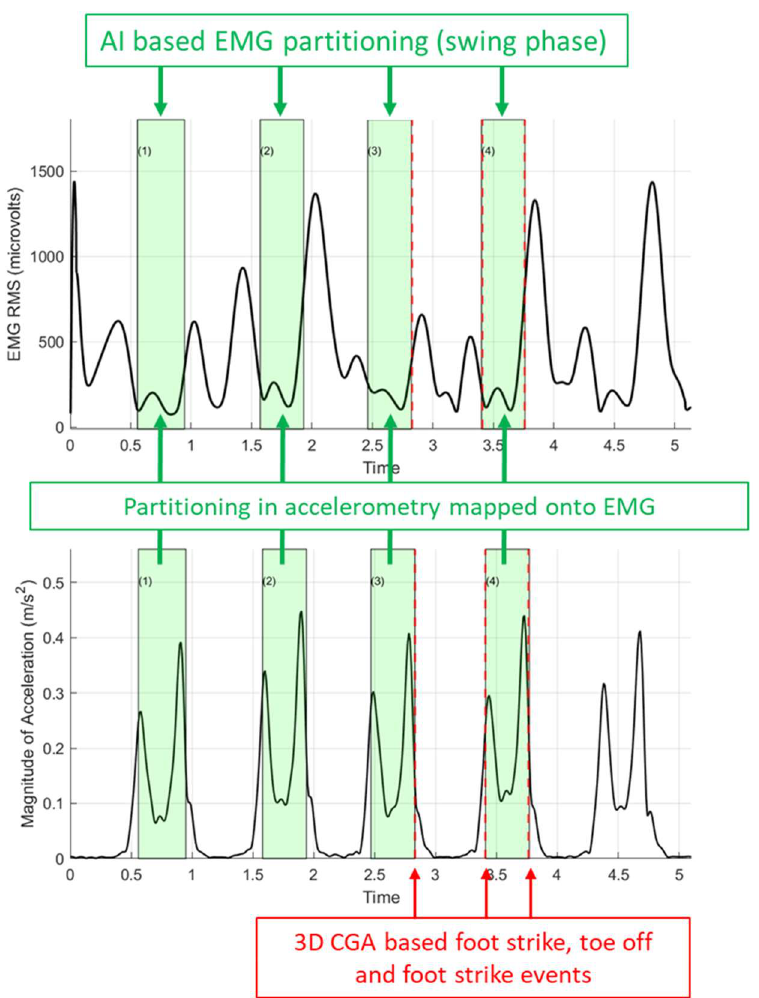
Figure 4. Representative sample of AI-based EMG partitioning of the right gastrocnemius muscle. The upper panel shows the Oro Muscles EMG envelope of a representative participant; the lower panel shows the accelerometer signal from the right IMU foot sensor; the green shaded areas indicate the AI-based partitioned swing phase (1–4 gait cycles); the dashed vertical red line indicates the 3D CGA-based identifications of foot-strike and toe-off events (red arrows from left to right).